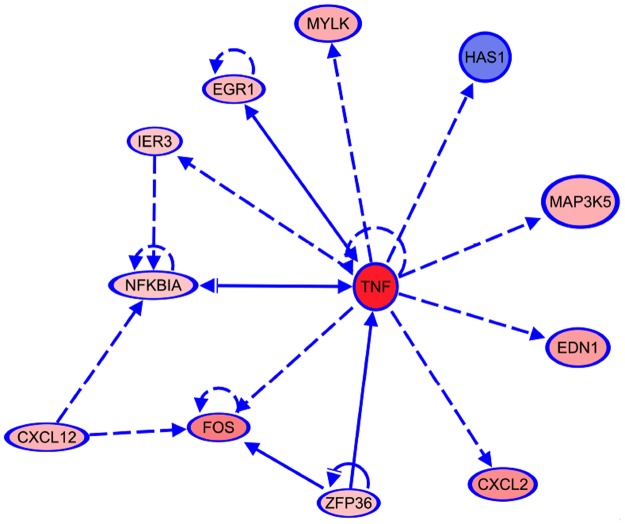
TNF is an upstream regulator of ten of the differentially regulated genes.The connections between nodes represent direct (solid lines) and indirect (dashed lines) relationships between genes, as supported by information in the IPA database. Up-regulated genes are shaded red, and down-regulated genes are shaded blue, with the intensity of the colour indicative of the magnitude of regulation. Feedback loops indicate auto regulation.